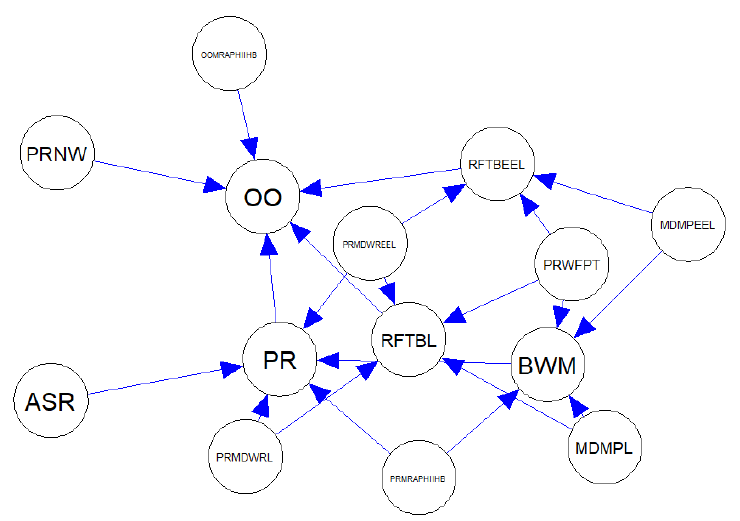
Figure 1. Directed acyclic graph (DAG) addressing the conditional dependencies of an extensive set of EHS variables.